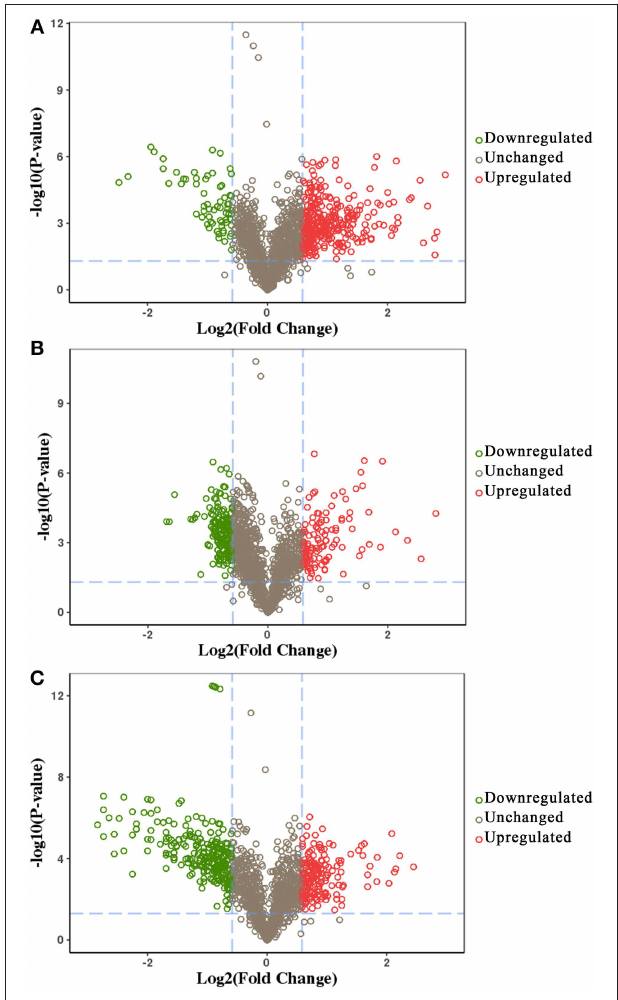
FIGURE 3 | Volcano plots showing the median phosphopeptides log 2 fold change plotted against the –log 10 P -value. The results highlight the phosphopeptides up/down-regulated in RH strain when comparing RH/PRU strains (A) , in PRU when comparing PRU/PYS strains (B) , and in PYS strain when comparing PYS/RH strains (C) , respectively. Red and green circles represent upregulated and downregulated DEPs, respectively. Dotted lines indicate ( ± ) 1.5-fold